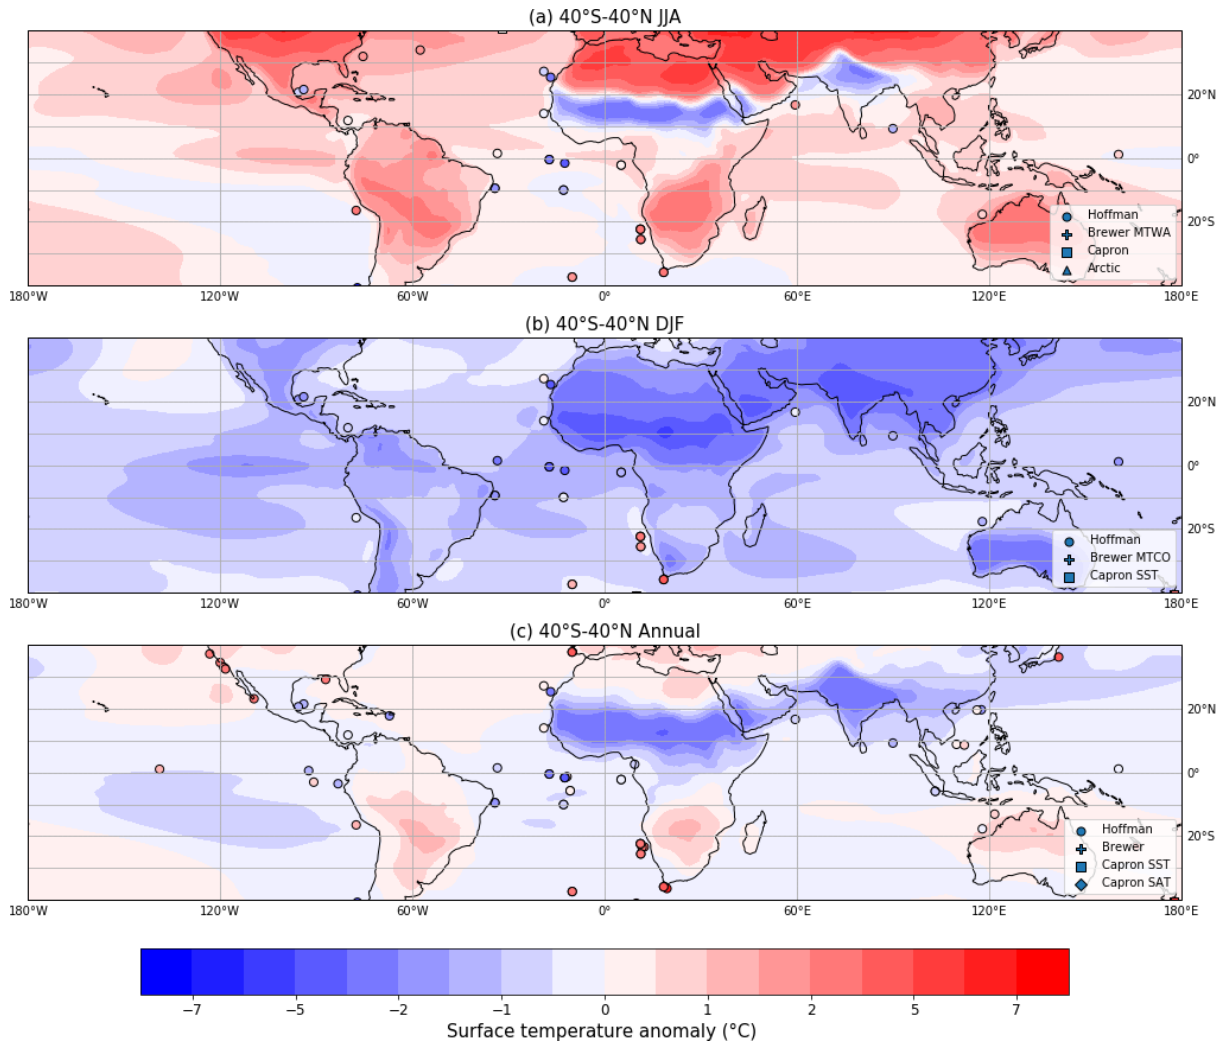
Figure 11. Same as Fig. 10 but for low-latitude (40 ◦ S–40 ◦ N) surface